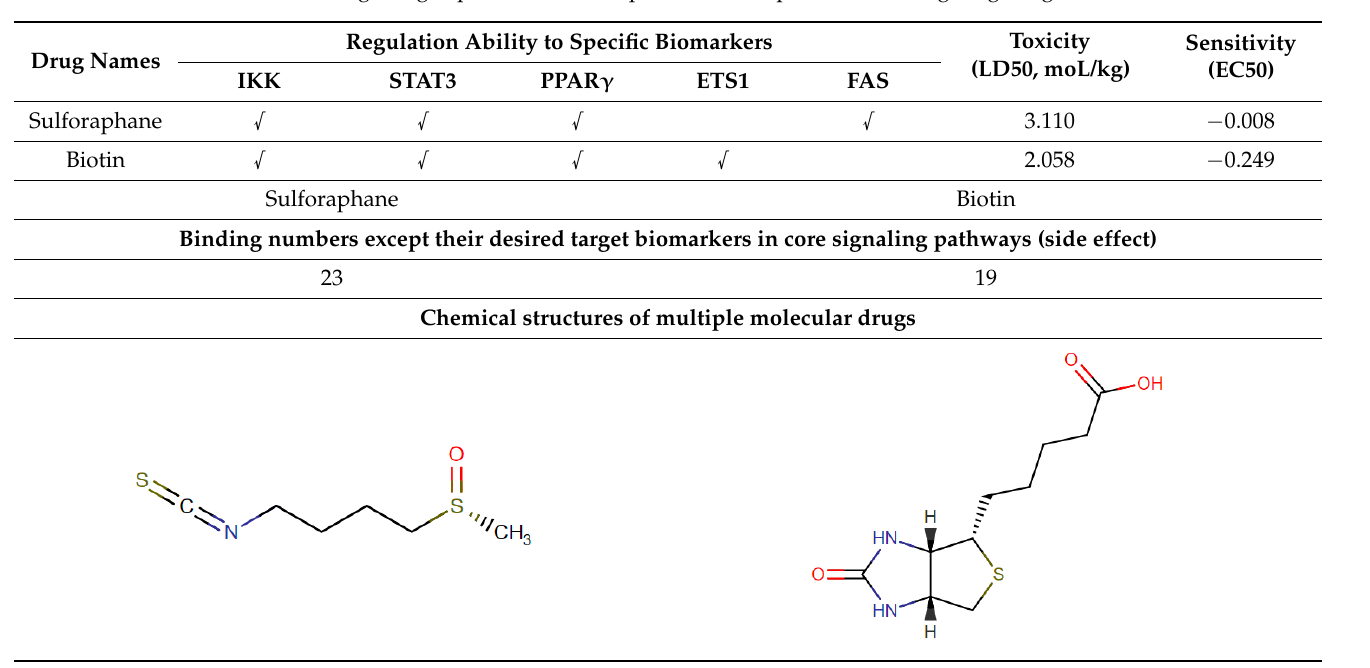
Table 7. The drug design specifications of a potential multiple-molecule targeting drug for